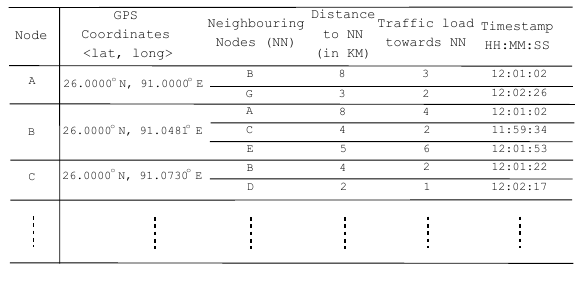
Figure 2. A sample Traffic flow map ( Ψ ) Algorithm 1: Monitoring Agent ( MA